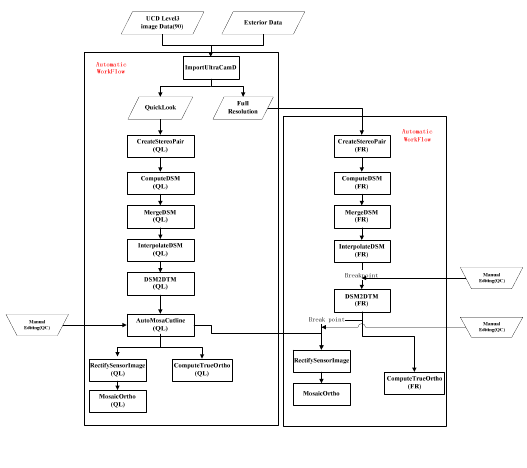
Figure 4. Tiepoints of UCD project 5.1.4 Digital Surface Model: The Digital Surface Model was computed by merging all individual Digital Surface Models